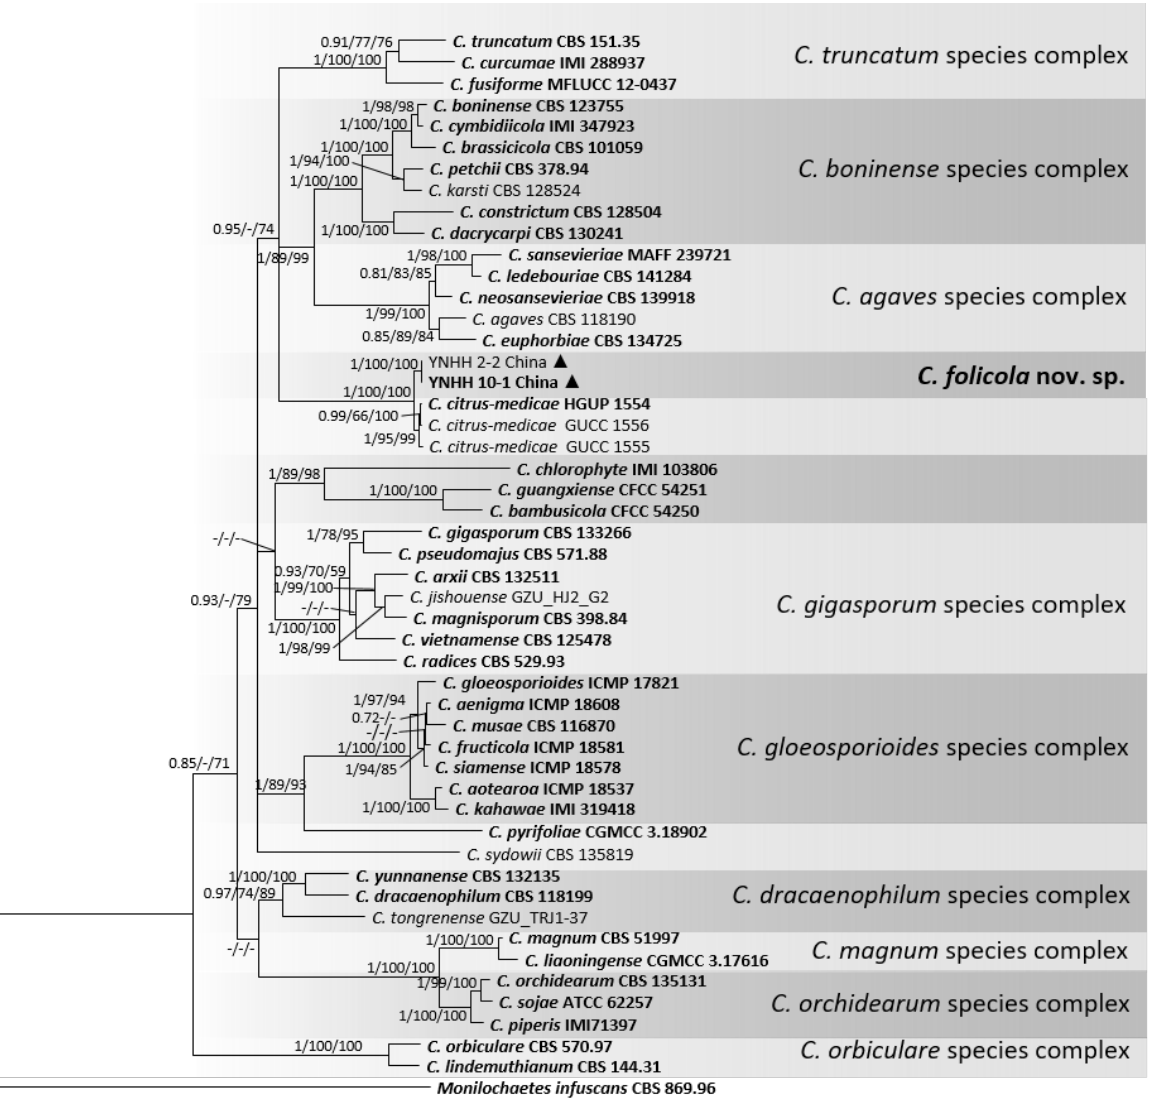
Figure 6. A Bayesian inference phylogenetic tree of 49 isolates of Colletotrichum spp. and outgroup. Monilochaetes infuscans (CBS 869.96) was used as the outgroup. The tree was built using combined sequences of the ITS, GAPDH , CHS-1 , ACT , and TUB2 . BI posterior probability values (BI ≥ 0.70), MP bootstrap support values (MP ≥ 50%), and RAxML bootstrap support values (ML ≥ 50%) were shown at the nodes (BI/MP/ML). Tree length = 4405, CI = 0.44, RI = 0.68, RC = 0.30, HI = 0.56. Ex-type strains are in bold. Circles indicate isolates from fruits, and triangles indicate isolates from leaves.